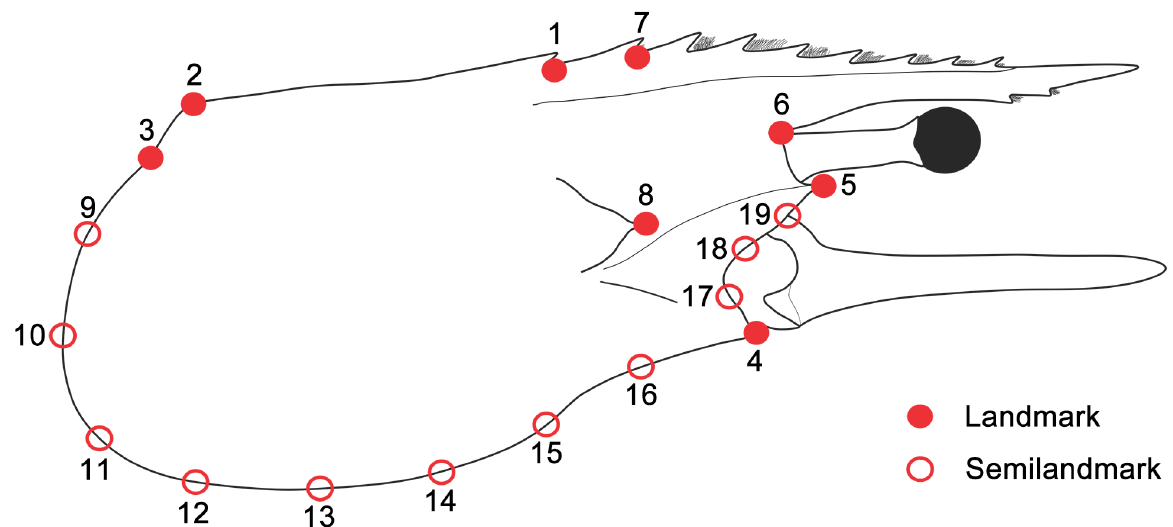
Figure 1. Location of landmarks and semi-landmarks on the cephalothorax right profile for investigation of geometric morphometry. Illustration from Litopenaeus vannamei (Boone,